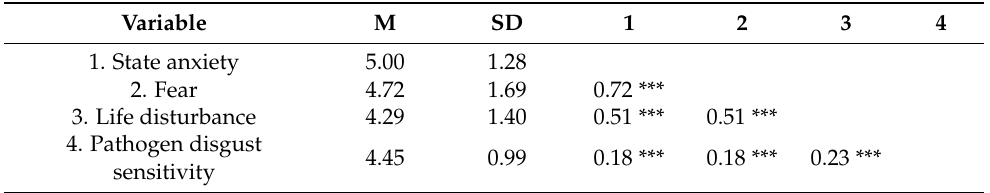
Table 2. Zero-order correlations among the key continuous